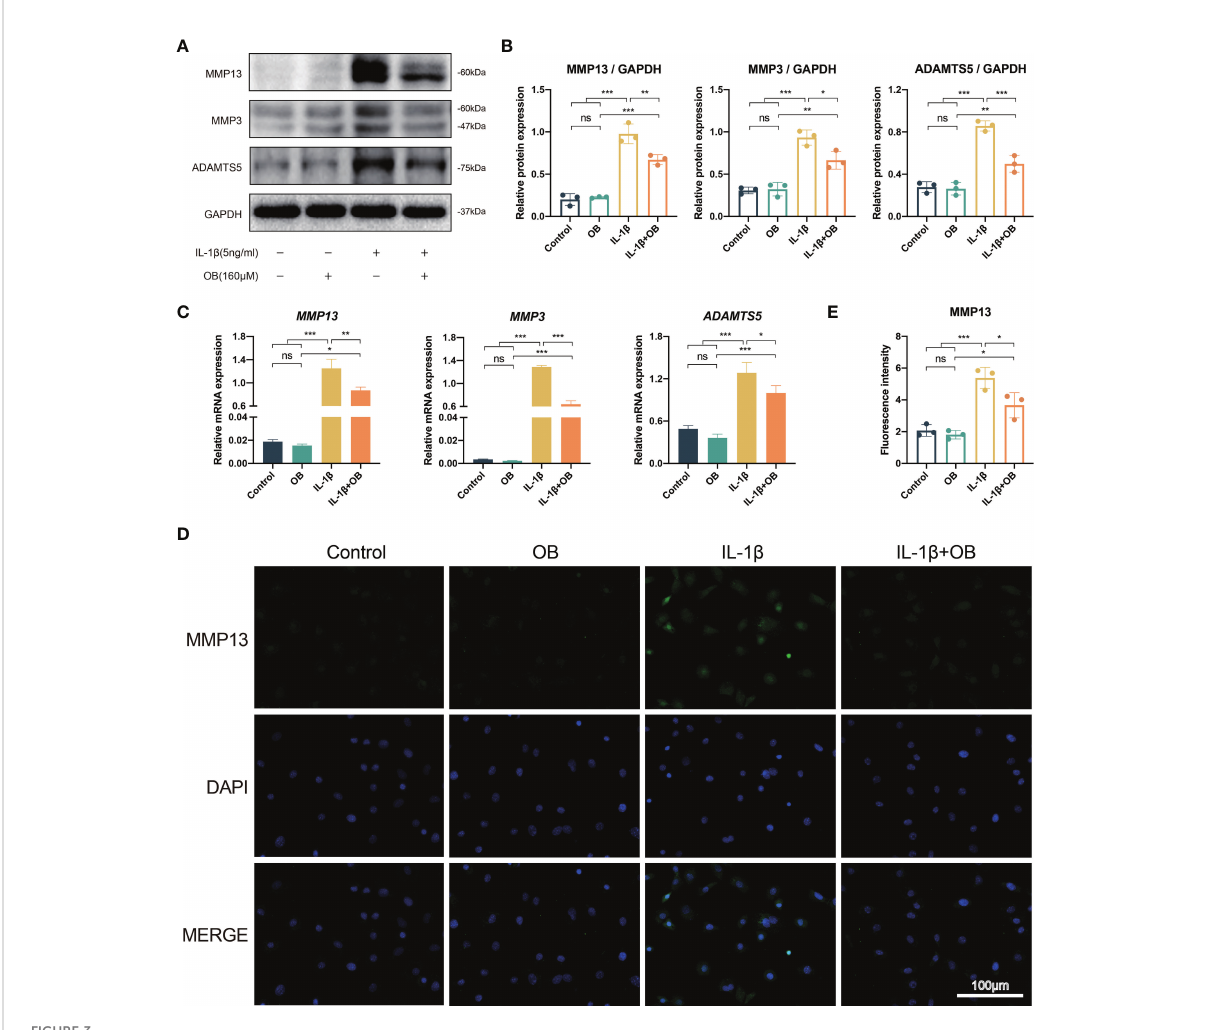
FIGURE 3 OB downregulated the catabolism in IL-1 b – induced chondrocytes. Chondrocytes were administered with IL-1 b (5 ng/ml) or/and OB (160 m M) for 24 h. (A) Western blot analysis and (B) quantitative data for the key catabolic-related proteins (MMP13, MMP3, and ADAMTS5). (C) Quantitative analysis of the catabolic-related (MMP13, MMP3, and ADAMTS5) mRNA expression by using RT-qPCR analysis. (D) Immuno fl uorescence staining and (E) quantitative data of the protein expression of MMP13. Data were presented as means ± SD (n = 3). ns, no signi fi cance; * p < 0.05; ** p < 0.01; *** p <